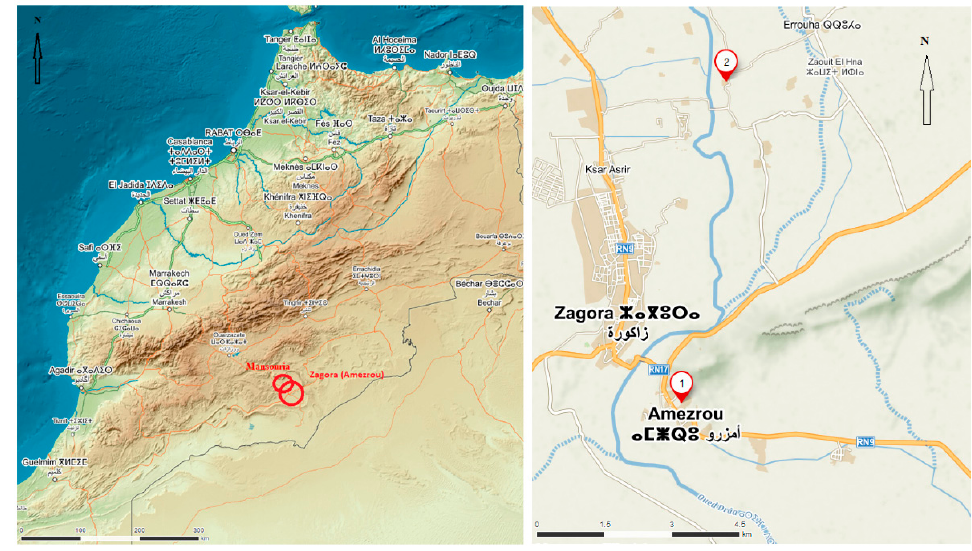
Figure 3. Map of Morocco with the location of both studied objects.